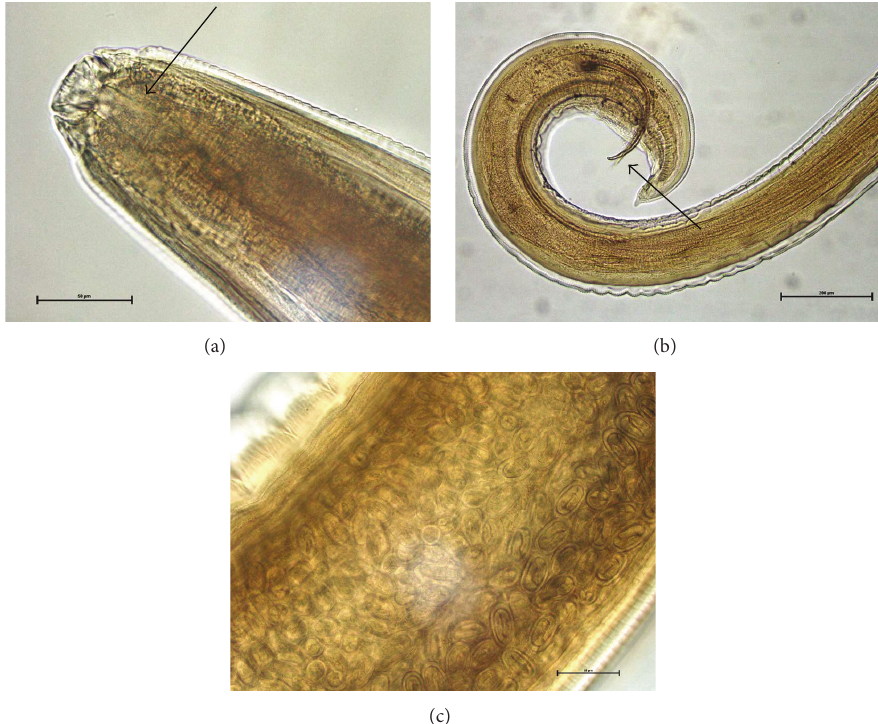
Figure 1: Whole mount of Procyrnea sp. nematodes from ventriculus of C. iris . (a) Anterior showing lips and cylindrical, chitinous buccal cavity (arrow). Scale bar = 50 𝜇 m. (b) Posterior aspect of male with copulatory spicule (arrow). Scale bar = 200 𝜇 m. (c) Uterus filled with thick-shelled, larvated eggs. Scale bar = 50 𝜇